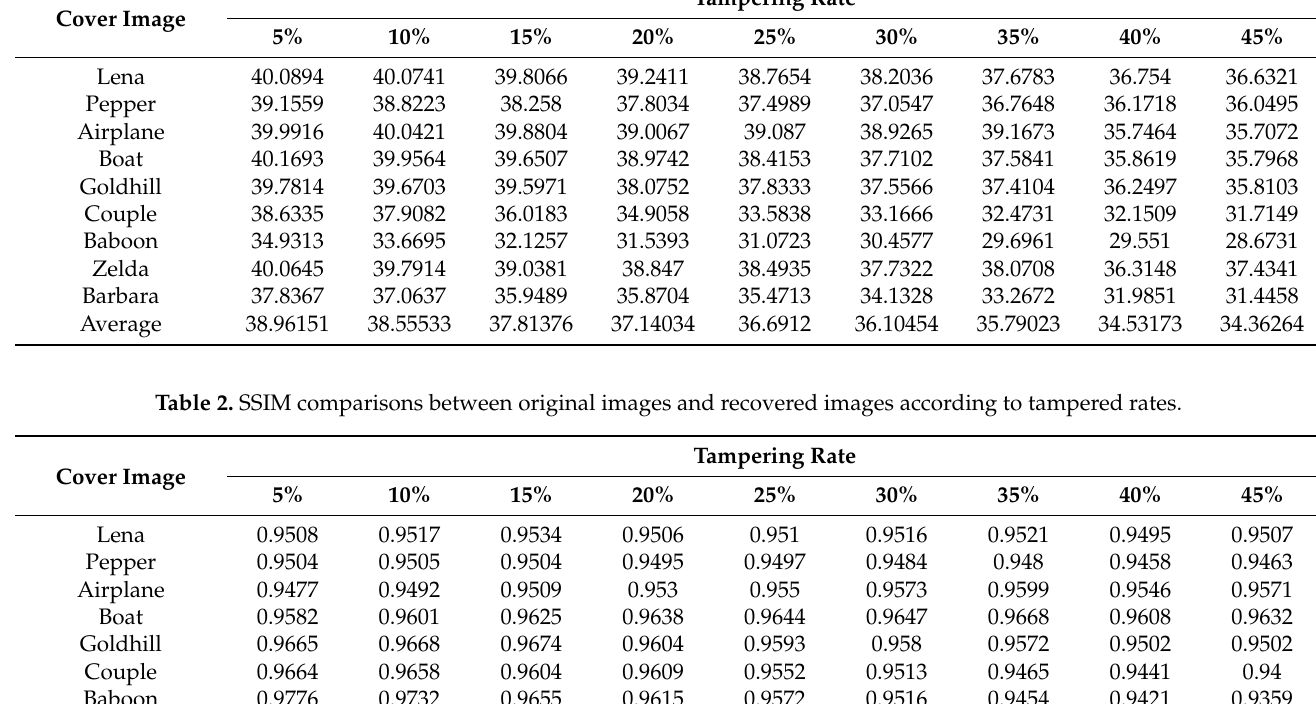
Figure 5. Cropping attack according to various ratios on Lena images and reconstructed Lena images applying the method we proposed. Table 1. PSNR comparisons between original images and recovered images according to tampered rates. Cover Image